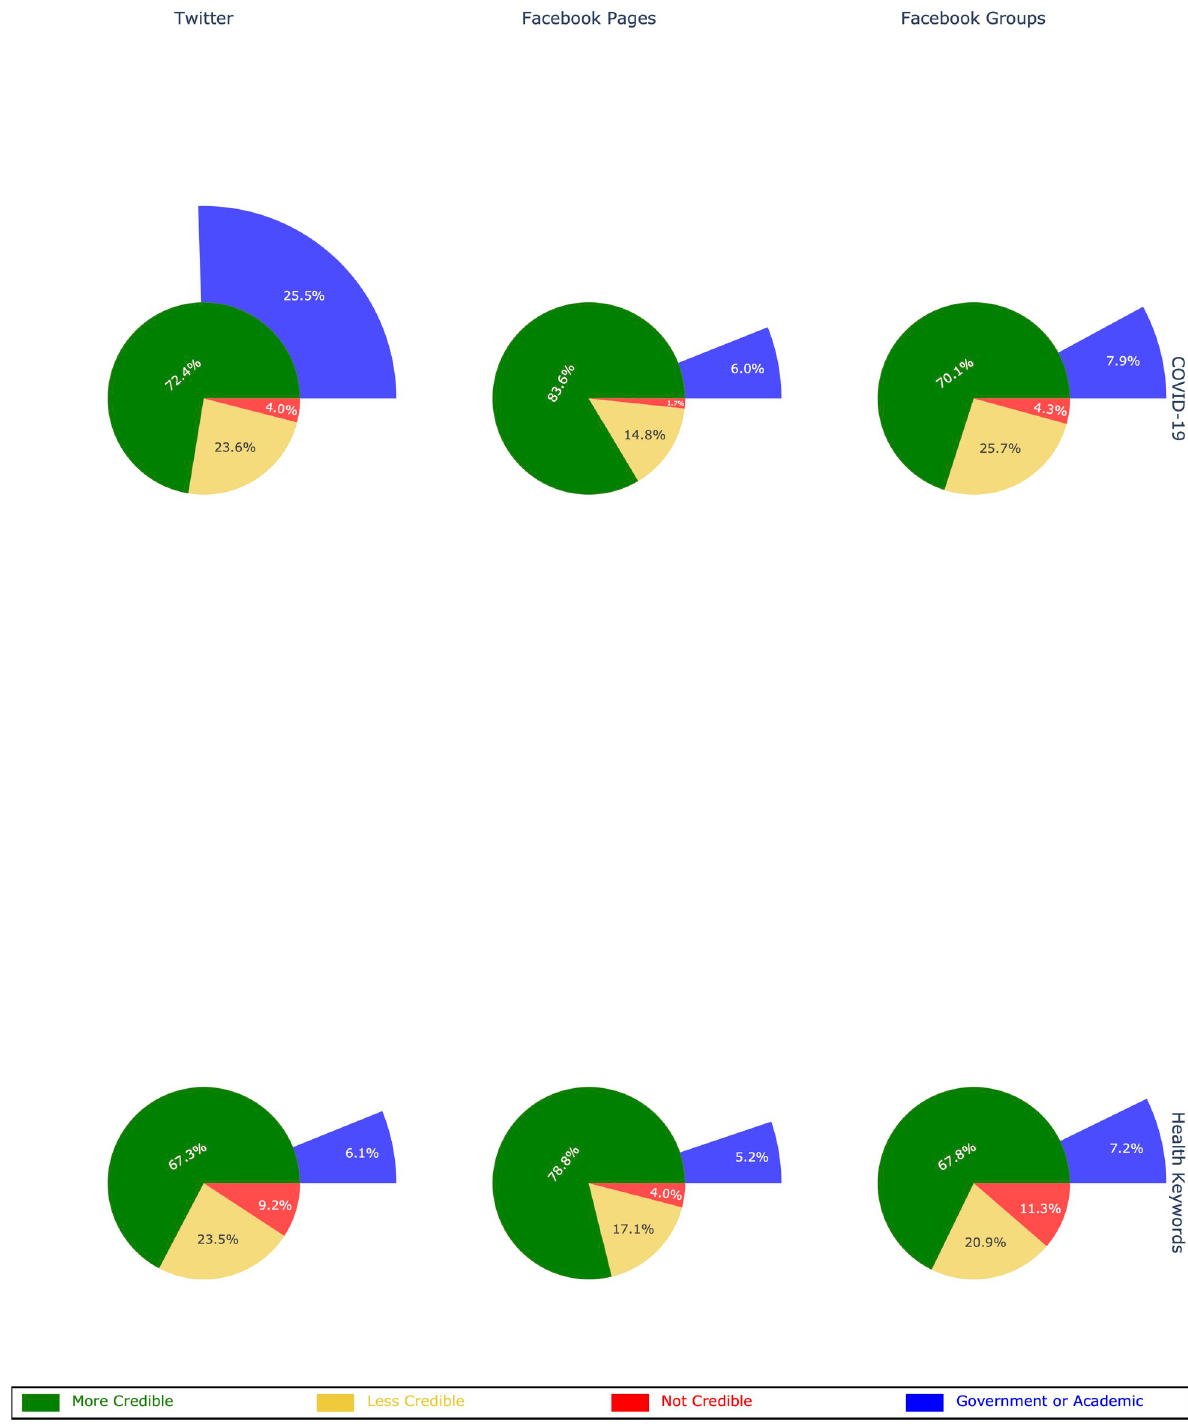
Fig 2. Proportions of COVID-19 and health URLs for each credibility category and social media platform.